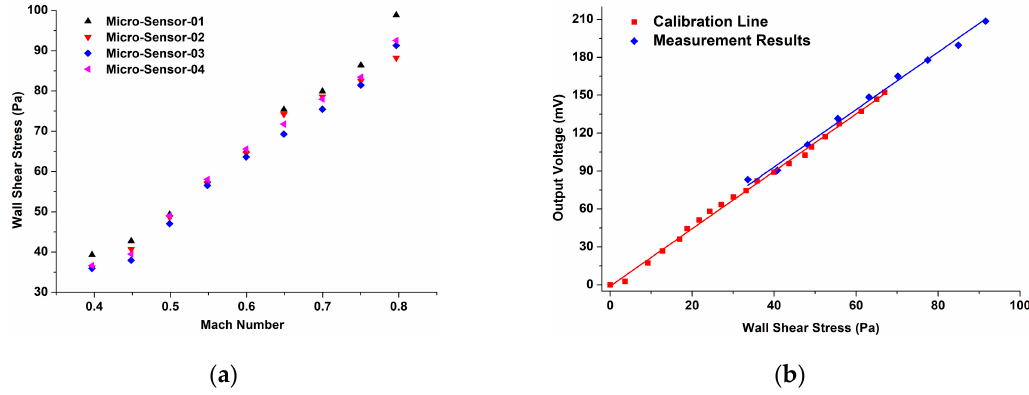
Figure 9. Wall shear stress obtained by the micro-sensor: ( a ) Three repetitive results of wall shear stress on the plate; ( b ) Comparison of the sensor calibration results and prediction results of wall shear stress by the sensor.